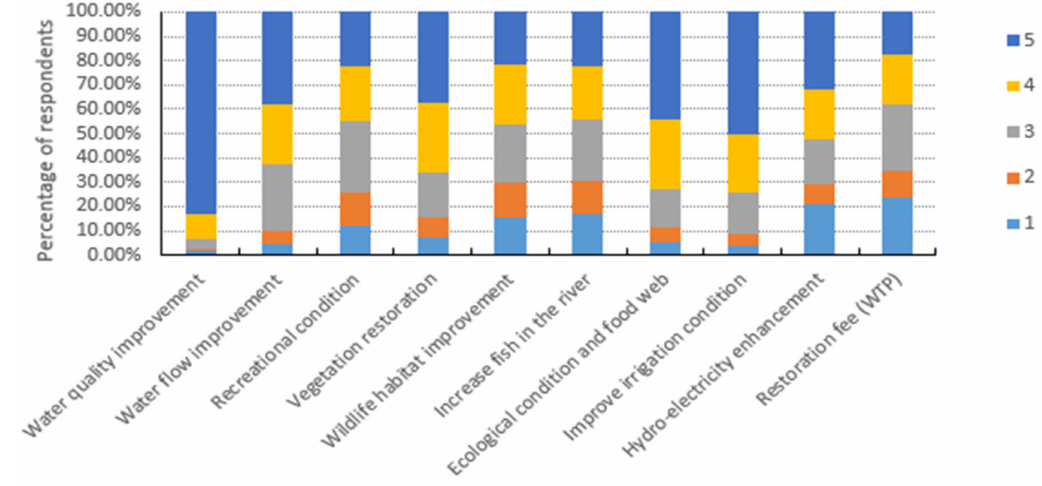
Figure 4. Importance of environmental policy interventions to improve ecological amenities, where the perception rankings ranged from “5” for very important to “1” for not important.